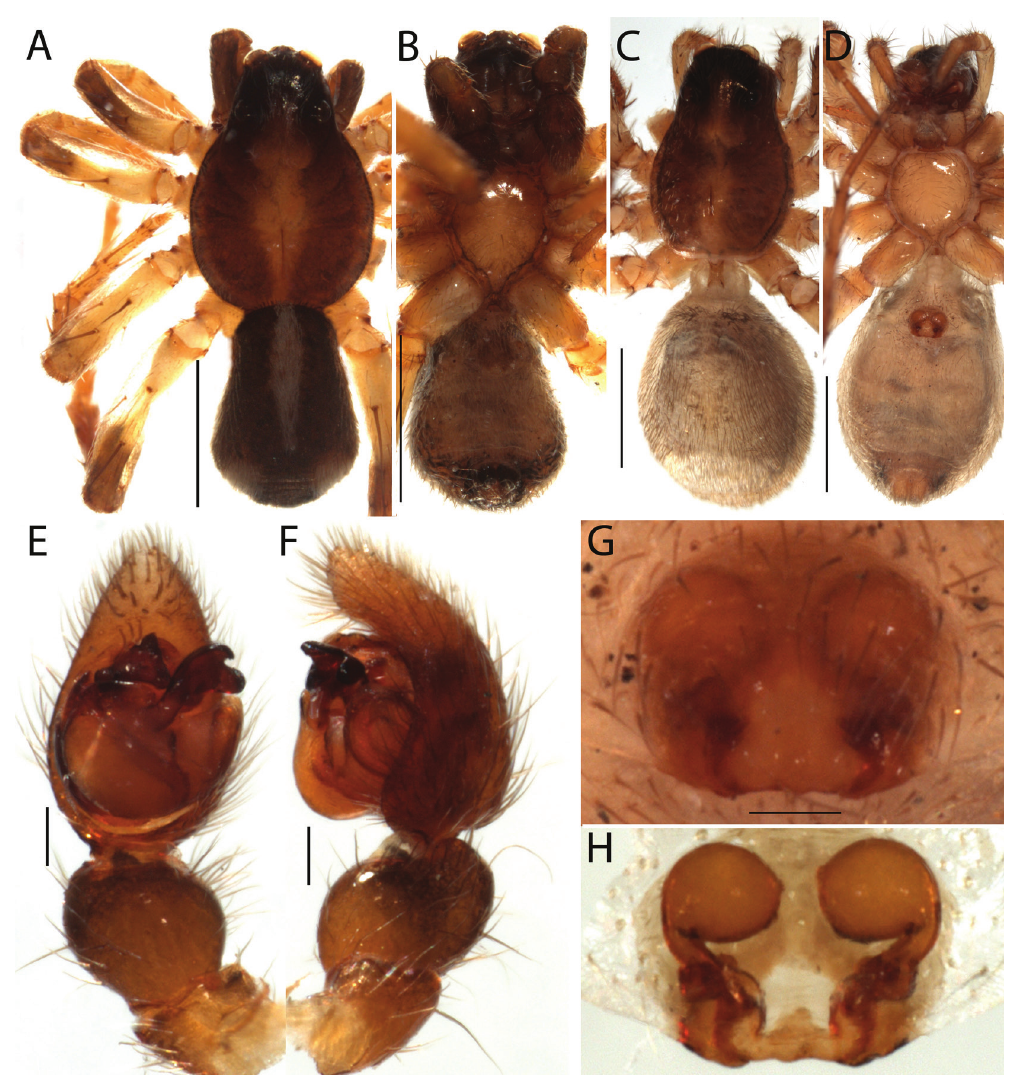
Figure 33. Artoria munmorah sp. n., male (AM KS128070), female (AM KS61980): A , male habitus, dorsal view; B , male habitus, ventral view; C , female habitus, dorsal view; D , female habitus, ventral view; E, male pedipalp, ventral view; F , male pedipalp, retrolateral view; G , epigyne, ventral view; H , epigyne, dorsal view. Scale bars: habitus 1.0 mm; pedipalp, epigyne 0.1